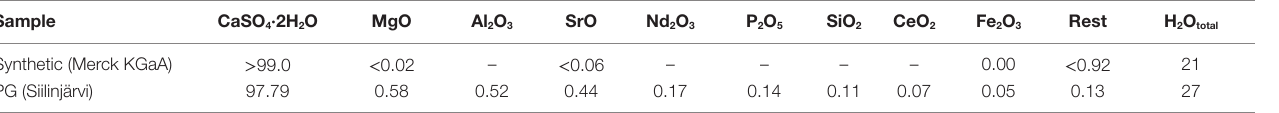
TaBle 1 | chemical composition (percentage of dry solids) of the gypsum samples, for Pg only elements > 0.05 wt.% listed. sample